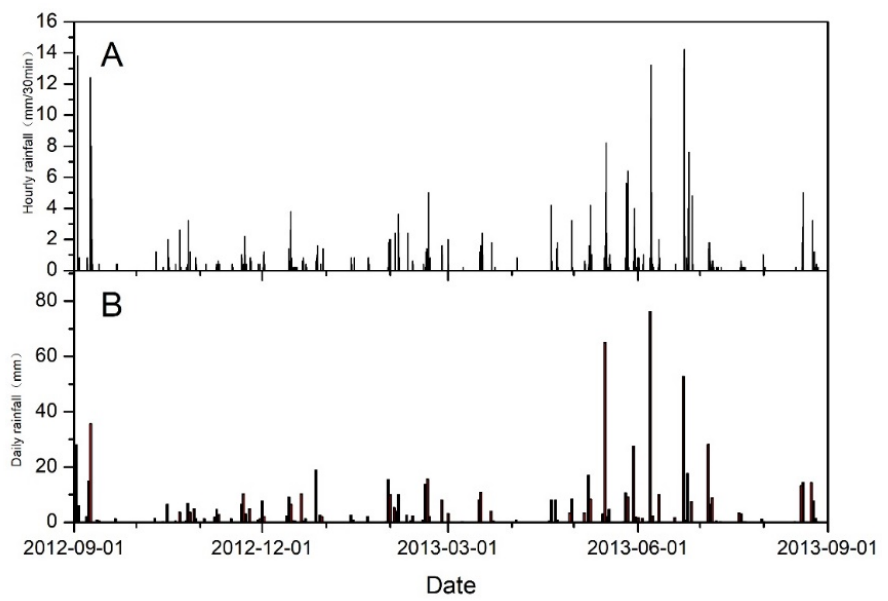
Figure A1. Seasonal course of daily mean photosynthetically-active radiation. (P ar ) ( A ), daily mean air temperature (T a ) ( B ), mean air relative humidity (R h ) ( C ), mean vapor pressure deficit (V pd ) ( D ), mean wind speed ( E ) between 9 September 2012 and 8 August 2013.